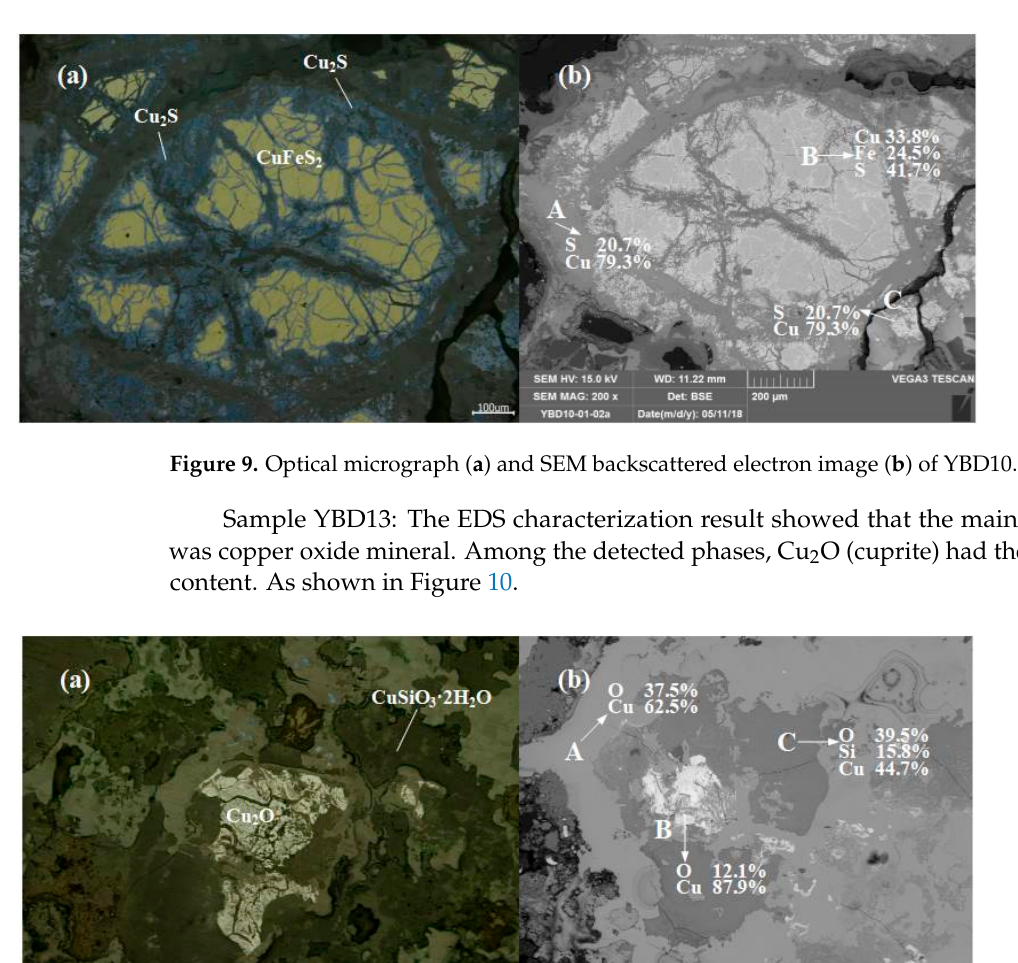
Figure 11. Optical micrograph ( a ) and SEM backsca tt ered electron image ( b ) of YBD19. 3.2.2. Slages without Detectable Copper Metal The II category of samples includes YBD05, YBD07, YBD08, YBD11, YBD12, YBD21, and YBD23. These samples were mainly copper smelting slag produced by pyrometallurgical processes. Due to the strong oxidizing atmosphere during smelting, most of the copper was oxidized and entered the slag in the form of Cu 2 O (cuprite) or Cu 2 O·Fe 2 O 3 (delafos- site) [16,17]. Sample YBD05: The crystal phases were Cu 2 O · Fe 2 O 3 (delafossite) and Cu 2 O (cuprite). Cu 2 O·Fe 2 O 3 (delafossite) crystals were well developed, while Cu 2 O crystals were elliptical and fi ll the space between Cu 2 O·Fe 2 O 3 (delafossite) crystals. No metallic copper particles were detected under a metallographic microscope. As shown in Figure 12.